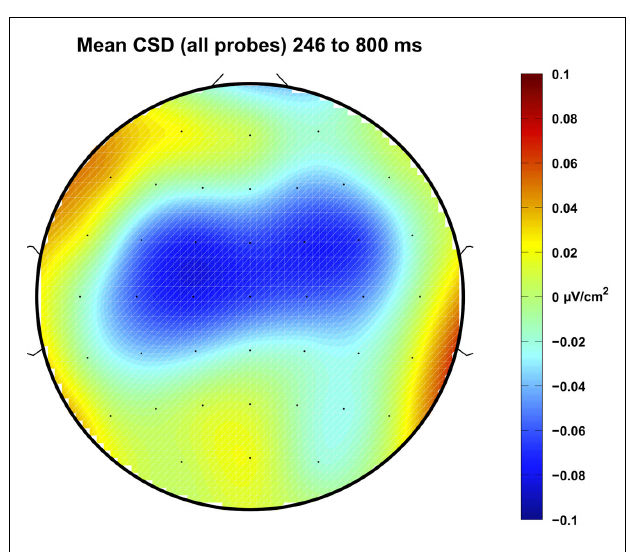
FIGURE 4 |The topographical distribution, viewed from above the head, of the mean current source density (CSD) between 246 and 800ms computed using trials from all probe durations. Prominent bilateral negative sources can be seen in the fronto-central region, consistent with the polarity and topography of the